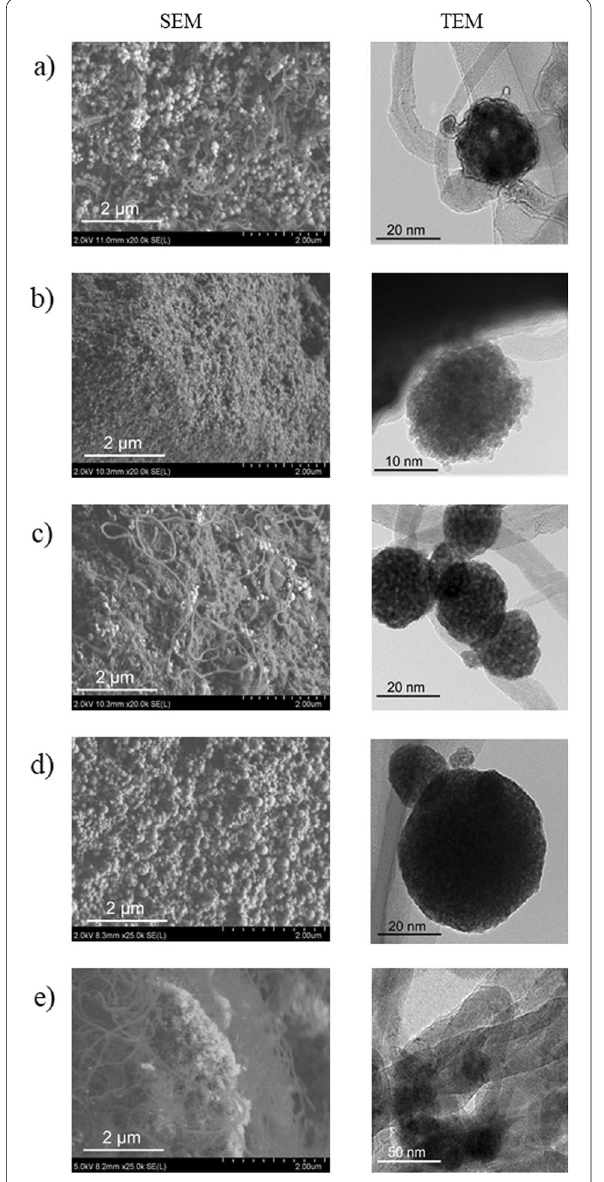
Fig. 7 SEM and TEM images of spent Ni catalysts embedded in